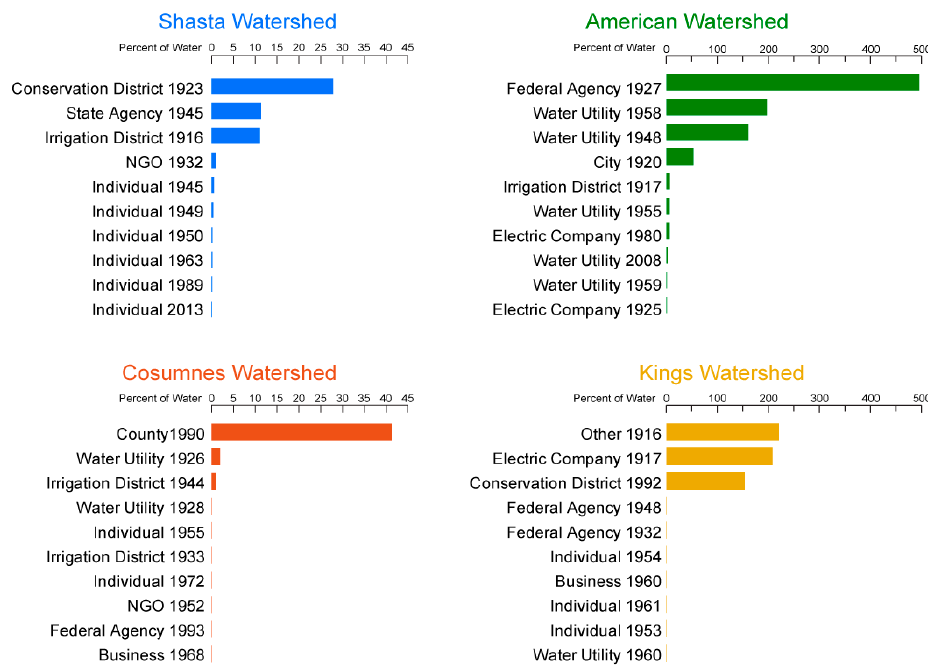
Figure 2. Volumes allocated, organization type, and year of permit for the 10 largest water rights holders by watershed. The x-axis indicates the total volume of allocated water rights as a percent of the mean annual runo ff ; the scale varies by watershed. Note that some organizations hold rights larger than the average annual runo ff